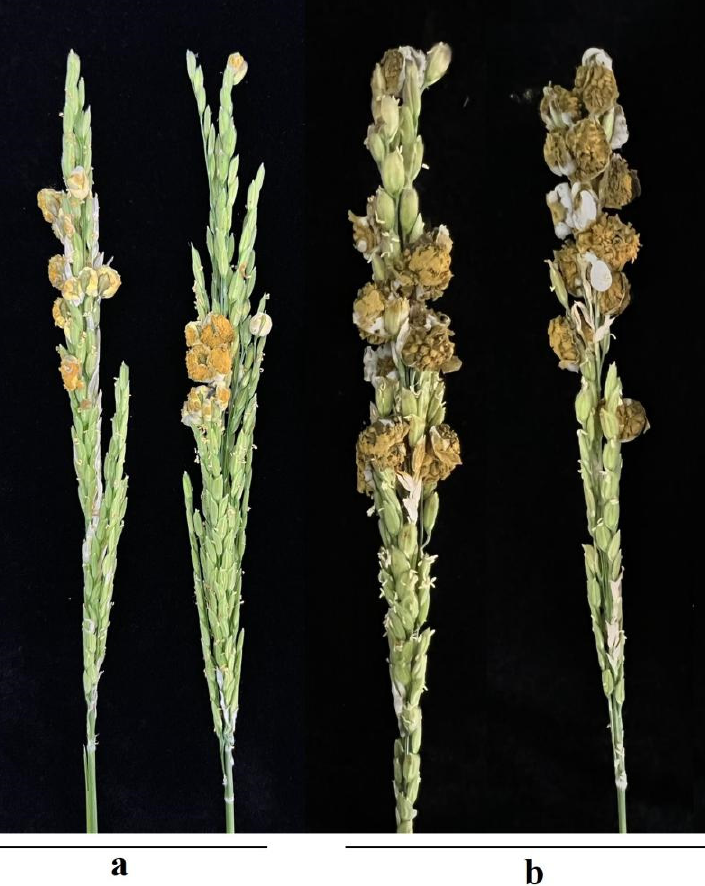
Figure 1. Symptoms of RFS. ( a ) A diseased rice panicle showing yellow false smut balls in a paddy field. ( b ) A diseased rice panicle showing greenish-black false smut balls in a paddy field.